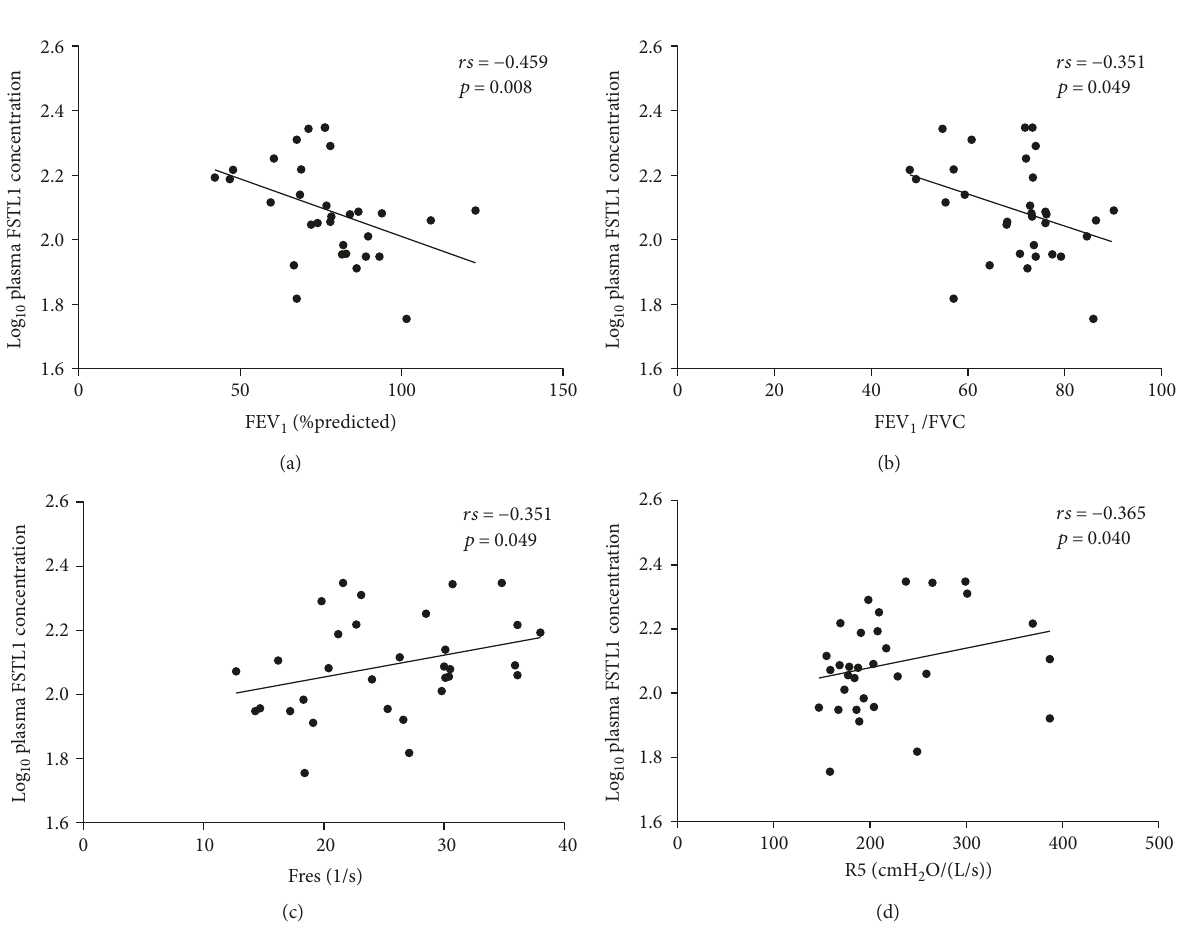
FSTL1 levels 10